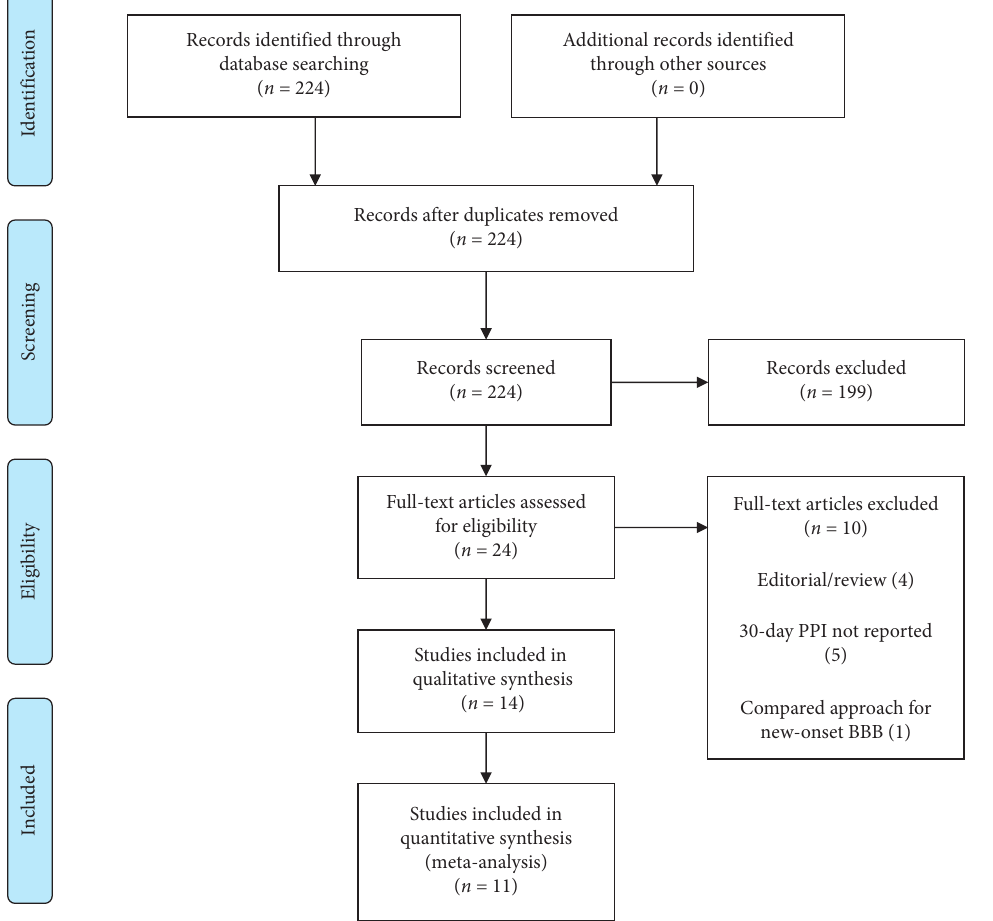
Figure 1: Flowchart of the included